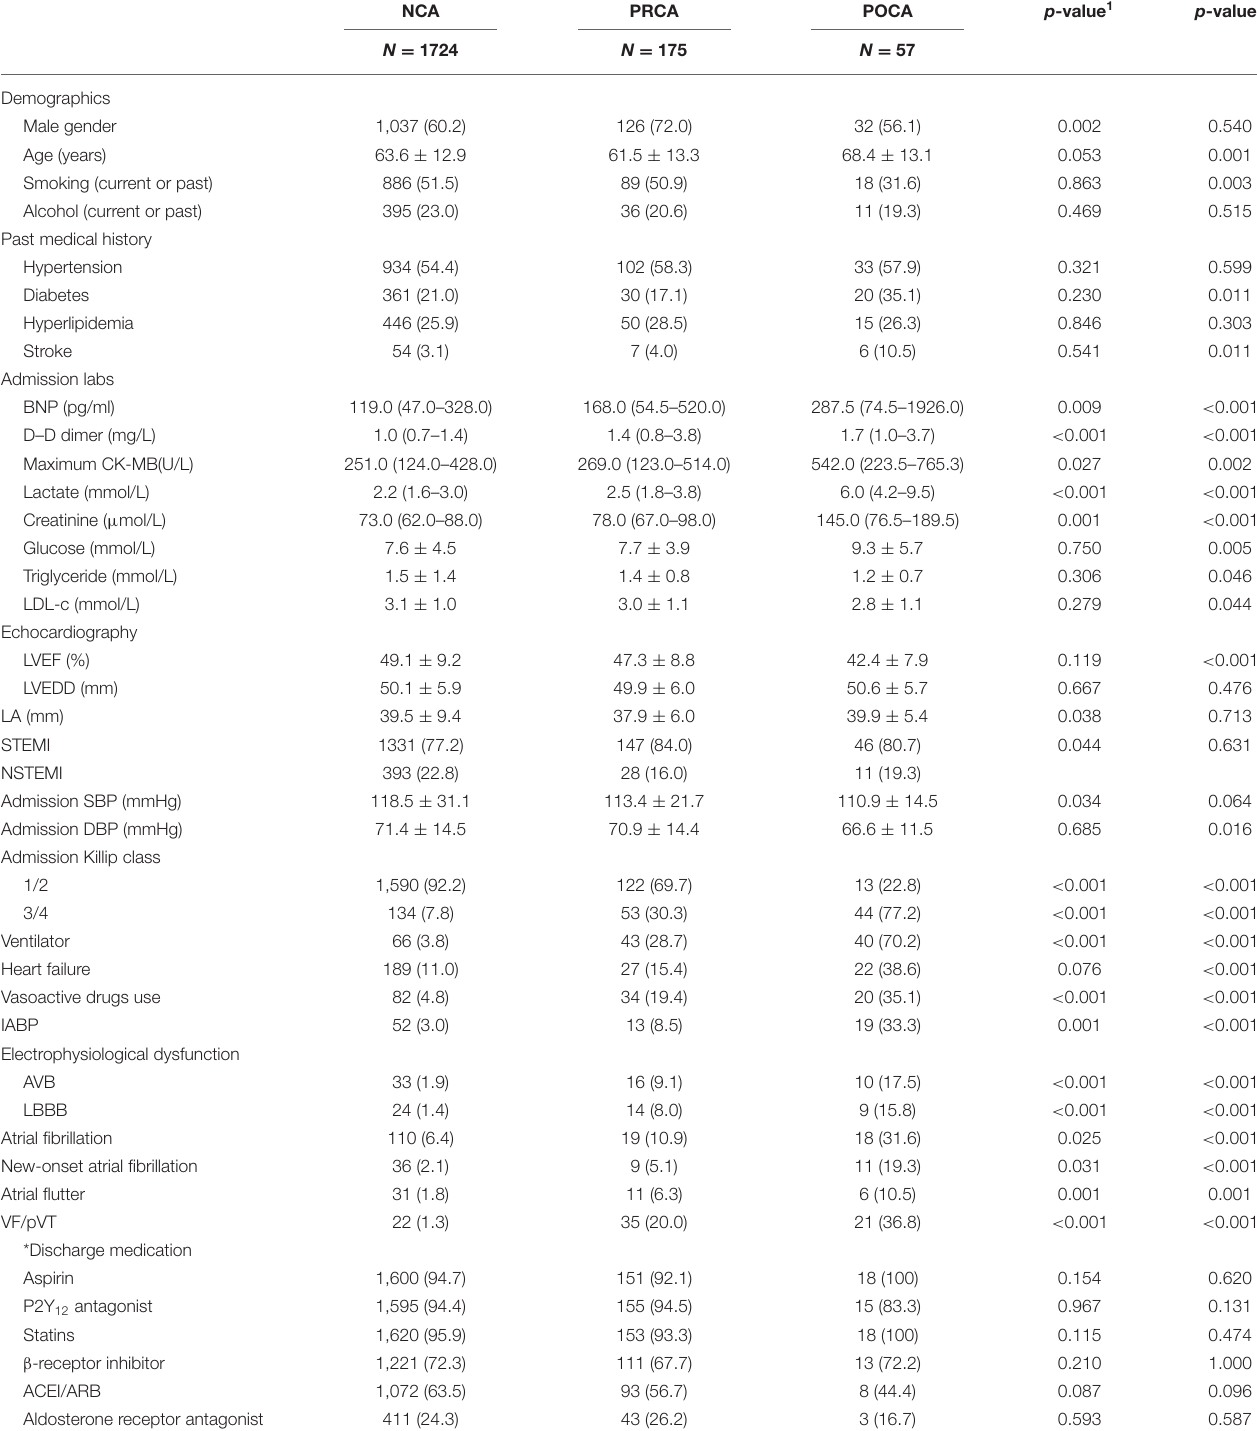
TABLE 1 | Baseline